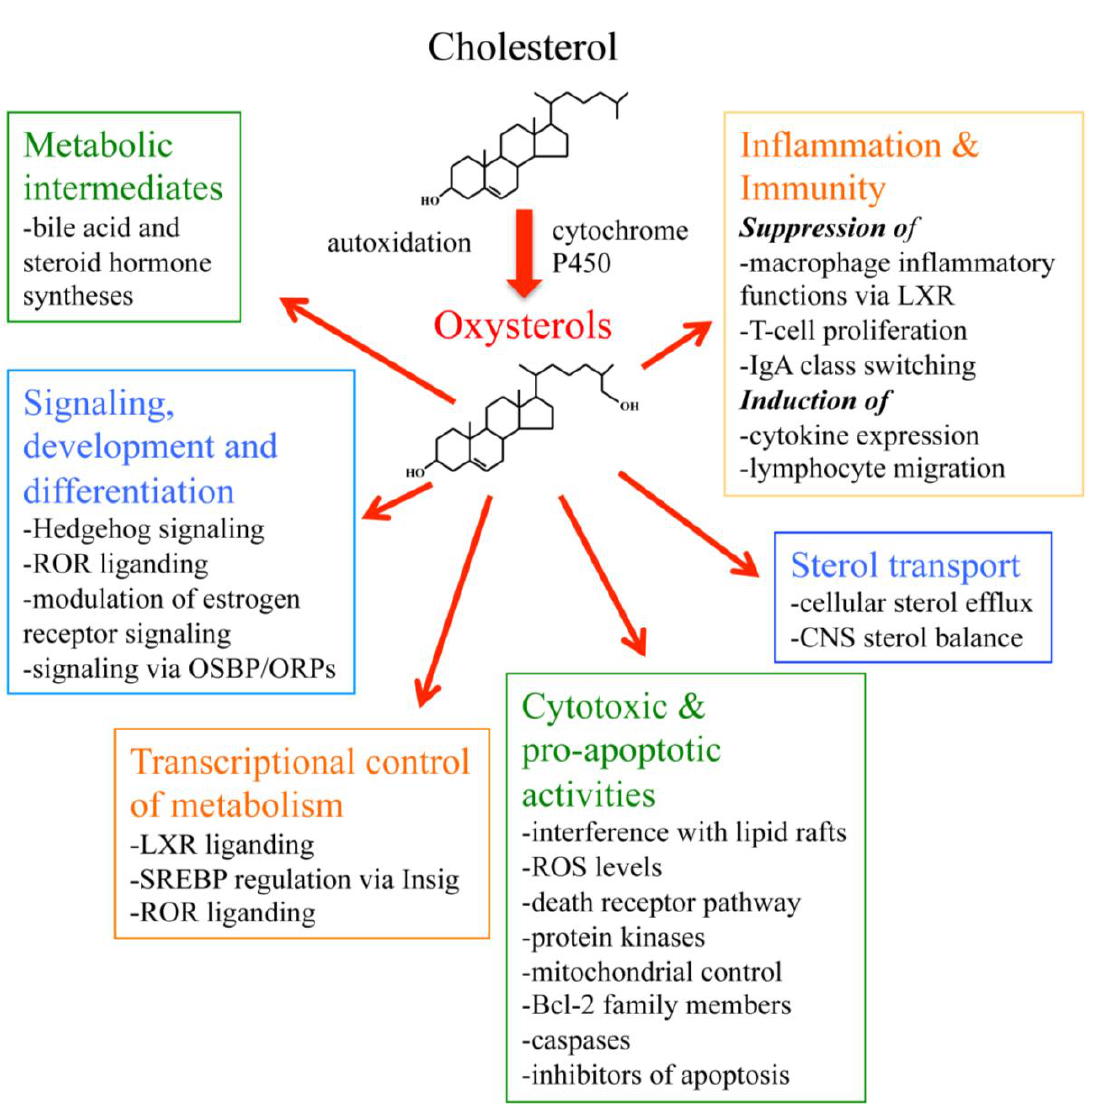
Figure 2. A schematic presentation summarizing the major functions of oxysterols. ROR, retinoic acid receptor-related orphan receptor; OSBP, oxysterol-binding protein; ORP, OSBP-related protein; LXR, liver X receptor; SREBP, sterol regulatory element binding protein; Insig, insulin-induced gene; ROS, reactive oxygen species; Bcl-2, B-cell lymphoma 2; IgA, immunoglobulin A; CNS, central nervous